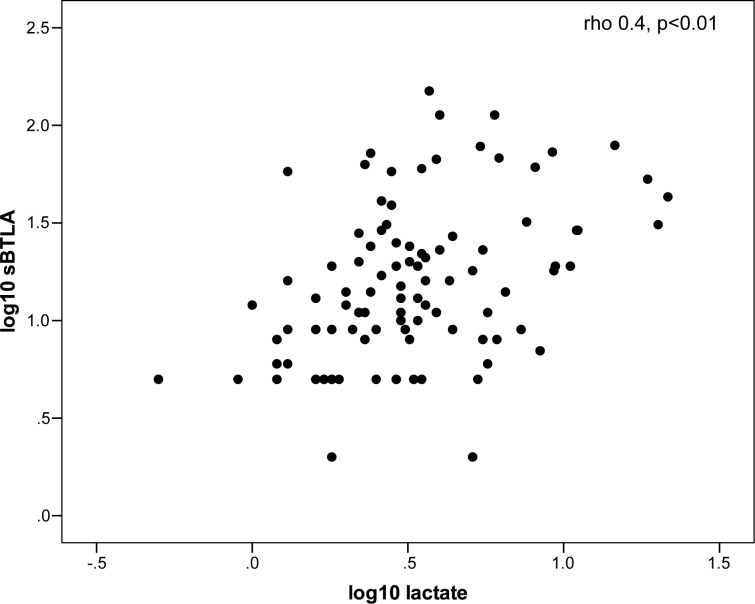
Correlation between baseline sBTLA and lactate in the sepsis cohort.Data is presented on log10 scales due to non-Gaussian distribution of both sBTLA and lactate.